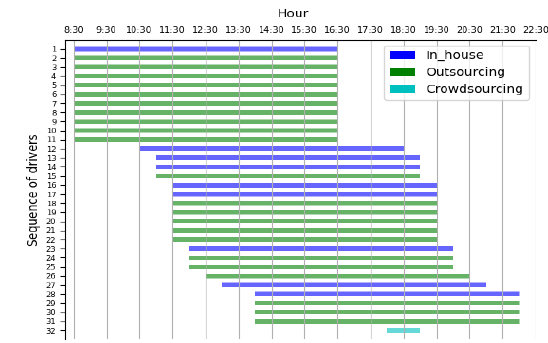
Fig. 8. Gantt chart for drivers’ work